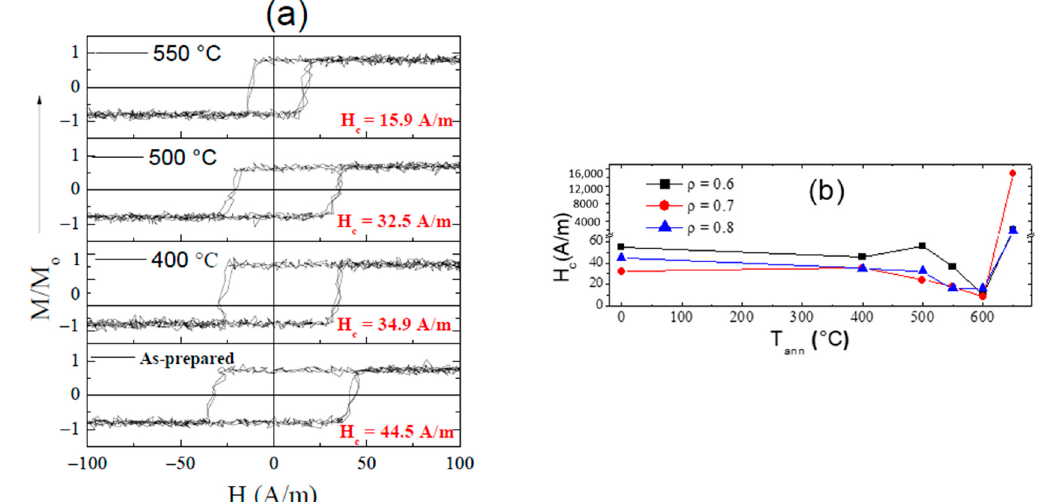
Figure 23. Hysteresis loops of as-prepared and annealed Fe 70.8 Cu 1 Nb 3.1 Si 14.5 B 10.6 microwire samples at T ann between 400–600°C ( a ); coercive field dependence on T ann of Fe 70.8 Cu 1 Nb 3.1 Si 14.5 B 10.6 for different ρ - ratios ( b ). (Reproduced with permission from [48] Copyright © 2016 Springer Nature).